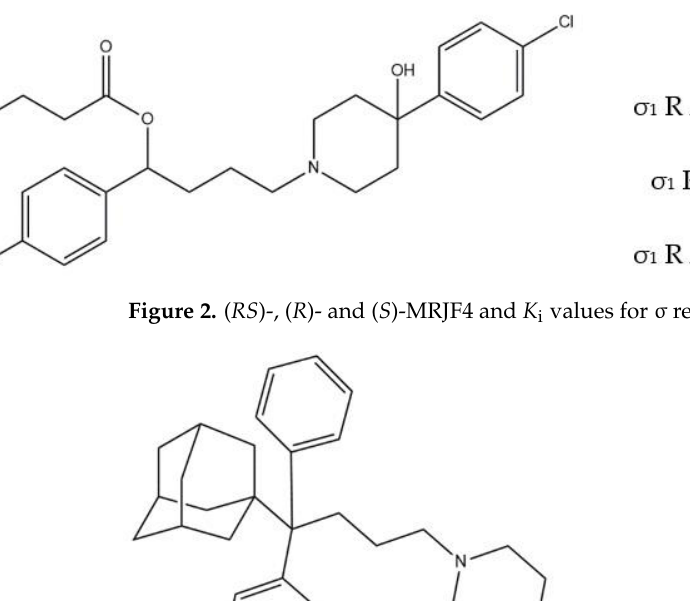
Figure 2. ( RS )-, ( R )- and ( S )-MRJF4 and K i values for σ receptors .